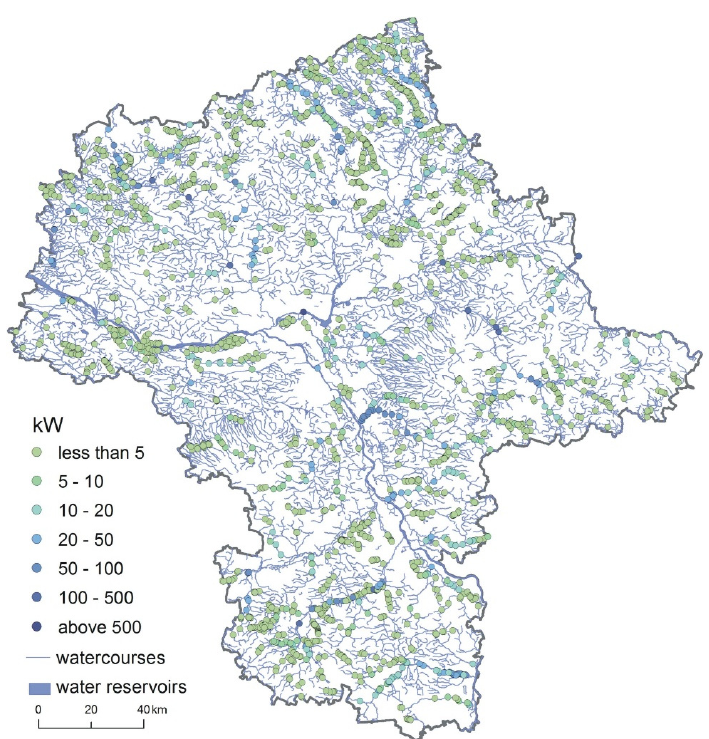
Figure 12. Localization of water dams and power of the potential hydropower plants in the Ma- zowieckie voivodeship (own elaboration).